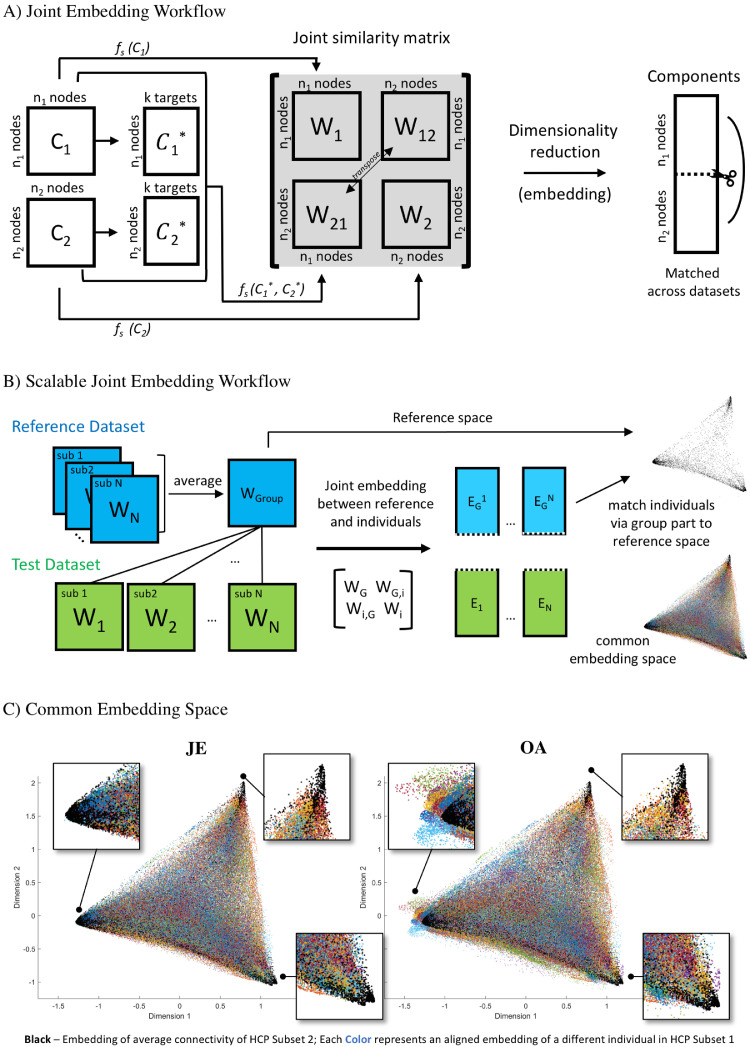
The joint embedding workflow. A) The rationale behind joint embedding. C denotes a connectivity matrix with n nodes, and f(C) the kernel to compute a similarity matrix W. B) The scalable joint embedding alignment across multiple subjects. C) Illustration of the common space established with joint embedding (JE), and alignment of individual embeddings (OA).